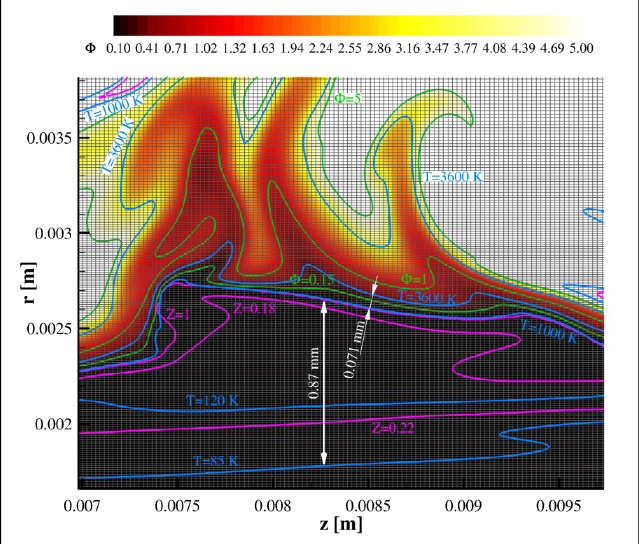
Figure 19. Instantaneous zoomed-in view of the equivalence ratio Φ close to the injector: three levels, 0.15, 1 (corresponding to the stoichiometric mixture fraction Z = 0.11) and 5 are marked as green iso-lines. Some temperature iso-level are shown in blue, while some compressibility factor iso-lines are in